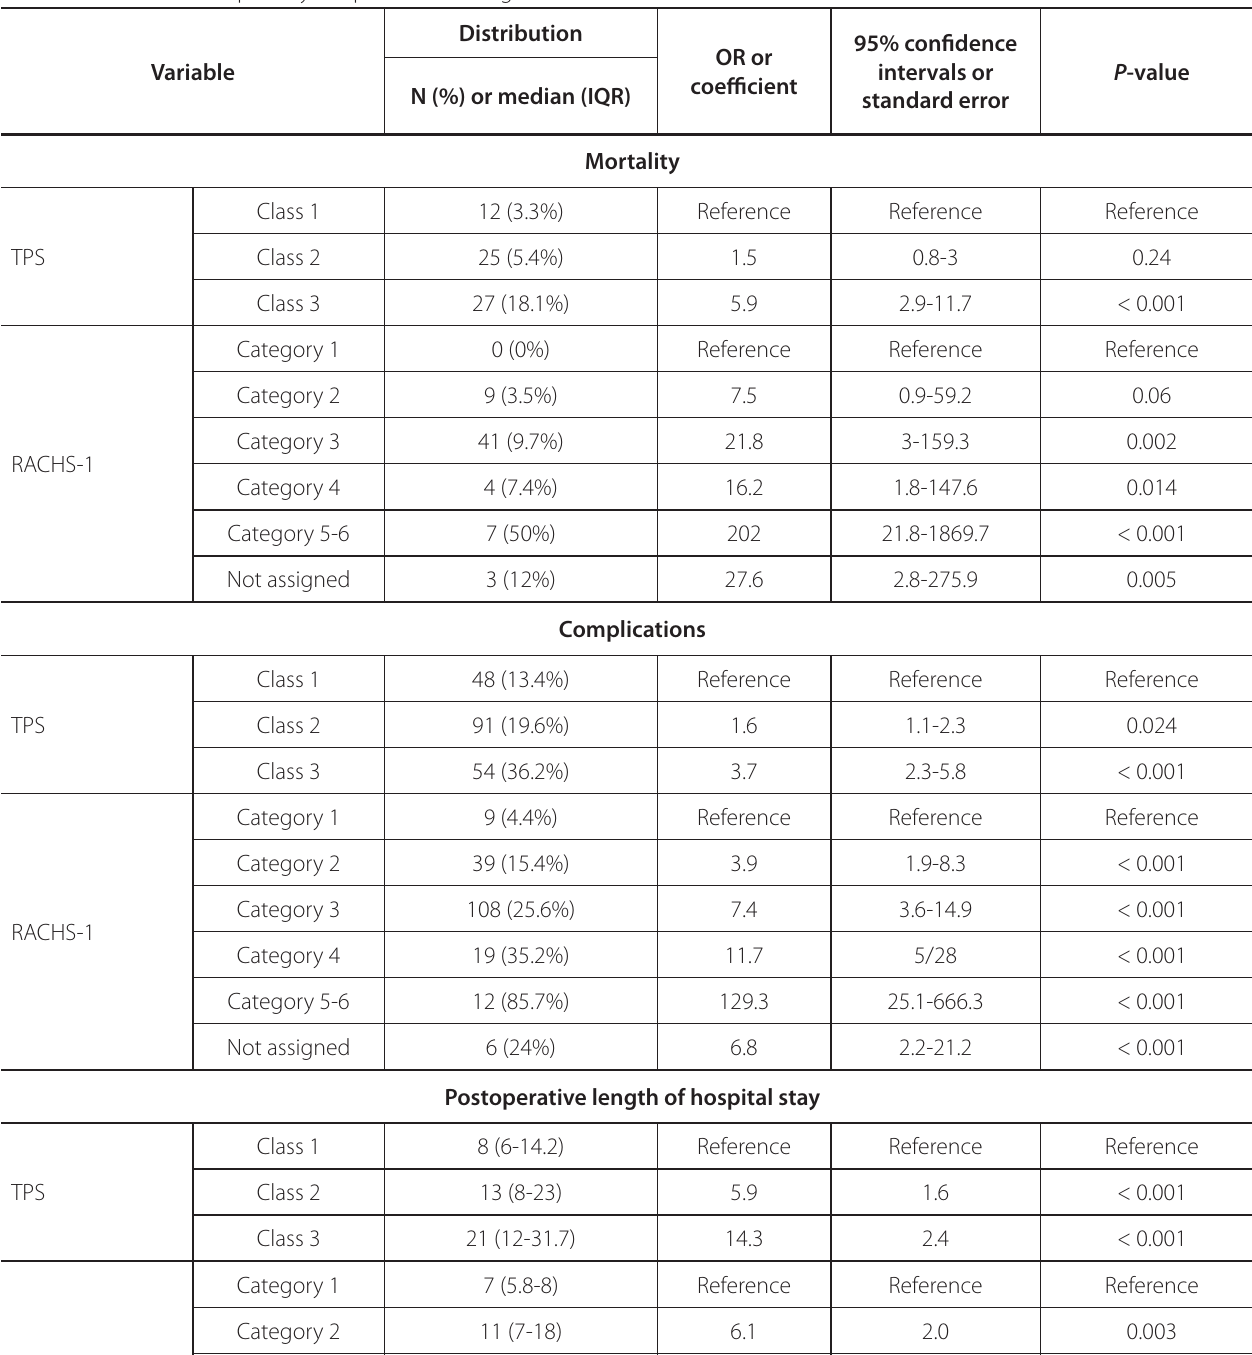
Table 2 . Distribution of primary endpoints according to TPS and RACHS-1.